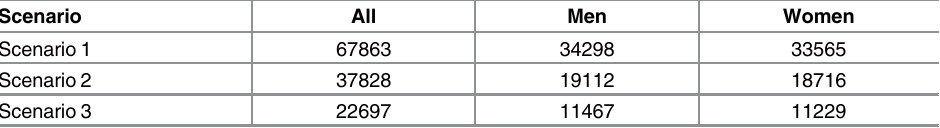
Table 1. Estimated number of patients developing ARF among those born in France between 1940 and 1960 under the different scenarios. Scenario